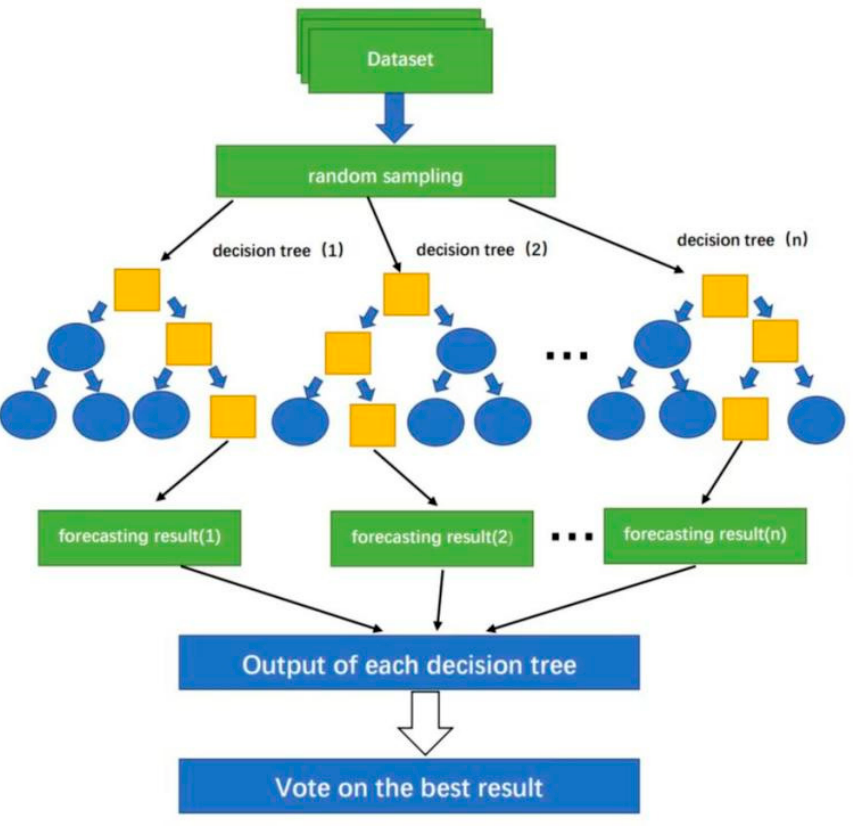
Figure 3. Schematic diagram of the RF algorithm.